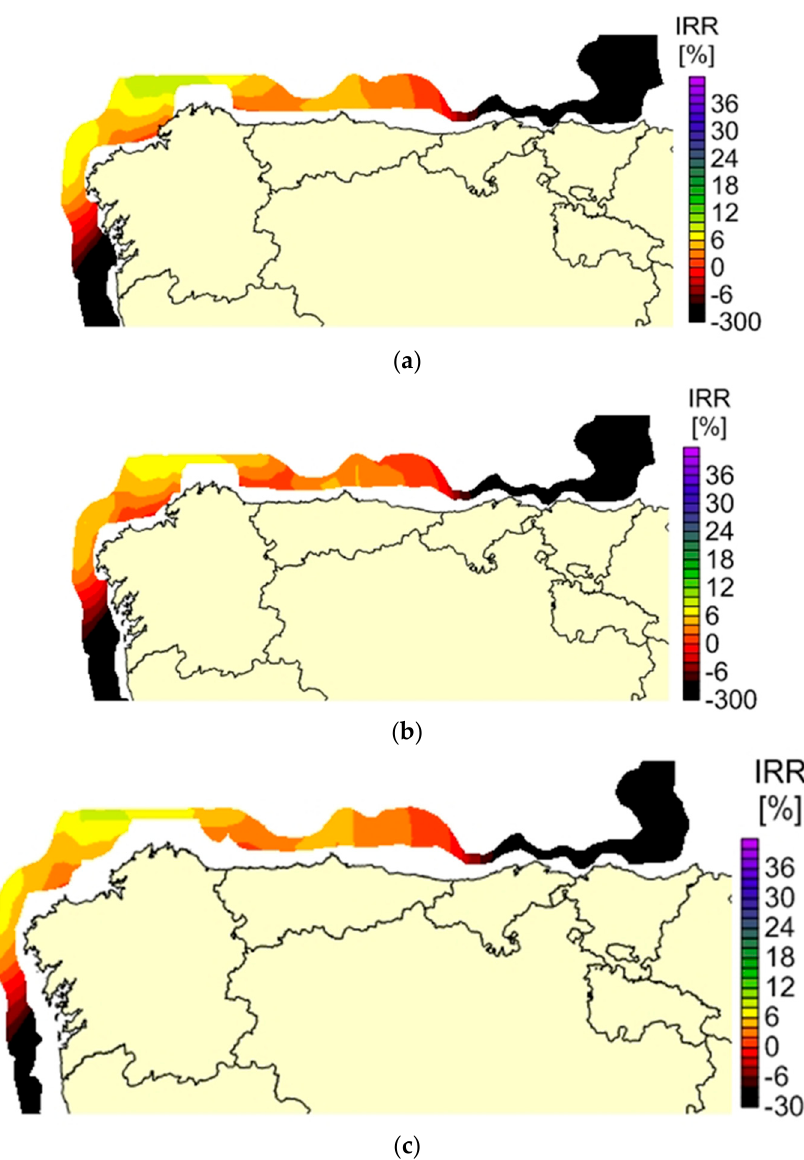
Figure 12. Results for internal rate of return (IRR) considering a tariff of 200 €/MWh and the bathymetry restriction for semisubmersible ( a ), tensioned leg platform ( b ), and spar ( c ).